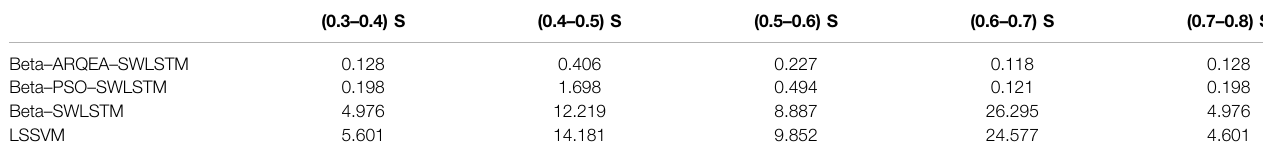
TABLE 2 | Fitting indicators in each wind speed grade of the four models.